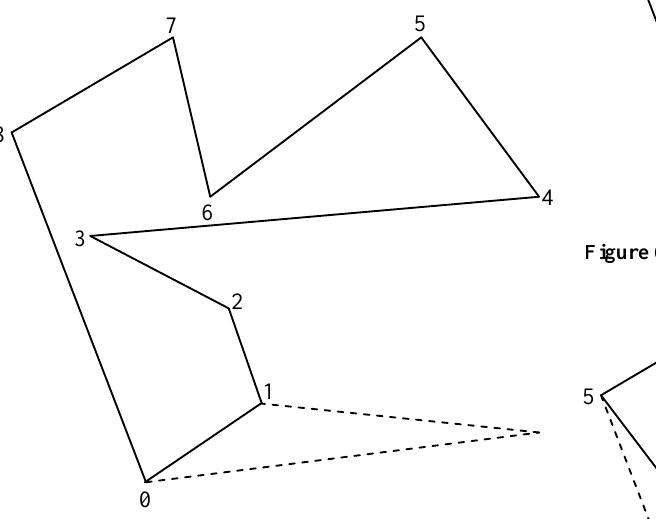
Figure 4: After pruning one ear